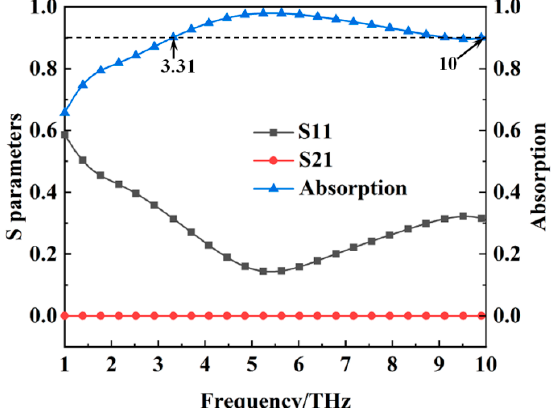
Figure 2. The S parameters and absorption of the metamaterial absorber when the conductivity of VO 2 film is 2 × 10 5 S/m.